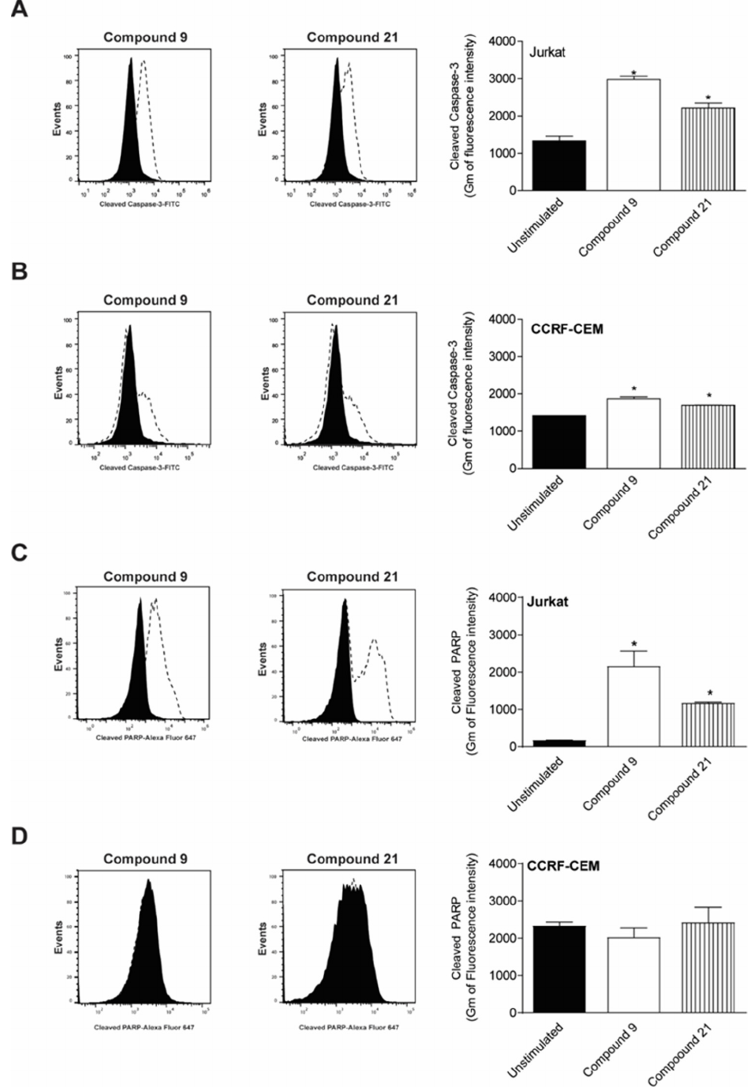
Figure 5. Quantification of cleaved ‐ caspase 3 and ‐ PARP by compounds. Jurkat and CCRF ‐ CEM cells at 2 × 10 5 cells/mL were used. Subsequently, cells were treated for 24 h with the respective EC 50 of the compounds. Levels of cleaved caspase ‐ 3 conjugated with FITC were quantified by flow cy ‐ tometry in ( A ) Jurkat and ( B ) CCRF ‐ CEM cells. Representative flow cytometry histograms are showed on the left. Levels of cleaved PARP were assessed using an anti ‐ cleaved PARP conjugated with Alexa Fluor 647 in ( C ) Jurkat and ( D ) CCRF ‐ CEM cells. The geometric mean of fluorescence is